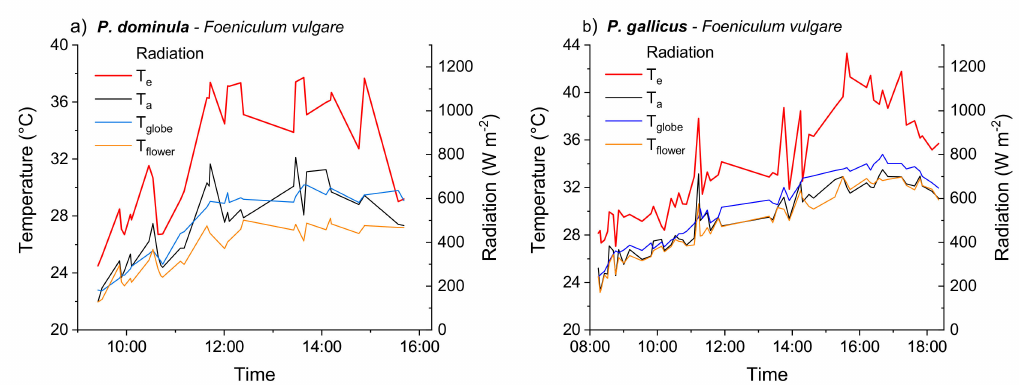
Figure 2. Time course of the operative temperature (T e ) measured with a dead wasp attached to an inflorescence, of microclimate data (T a = ambient temperature 1 cm beside the wasp, T flower = temperature in the inflorescence, radiation = solar radiation in the inflorescence), and of macroclimate data (T globe = temperature in shade beside the measurement location in 2 m height). ( a ) Polistes dominula in Gschwendt / Austria, and ( b ) Polistes gallicus in Sesto Fiorentino / Italy, measured at